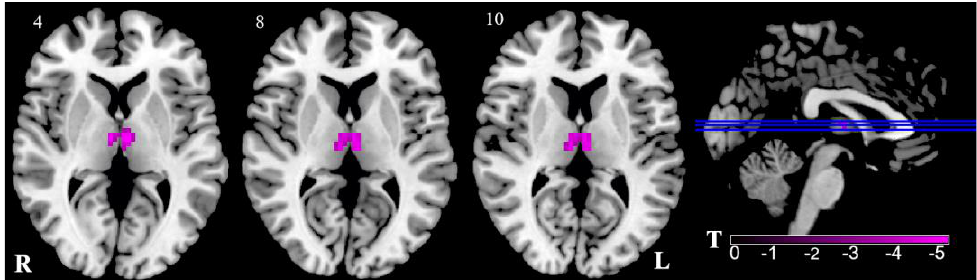
Figure 1. Regional ALFF reduction in VM patients in contrast to HC. Pink signifies decreased ALFF. The axial image was overlaid on the transverse section of the MNI-152 standard anatomical image. Blue line represents the layers in the sagittal. Numbers indicate z slice. The color scale denotes the t-value. R, right; L, left. Table 2. Regions of reduced ALFF in VM patients compared with HC. Brain